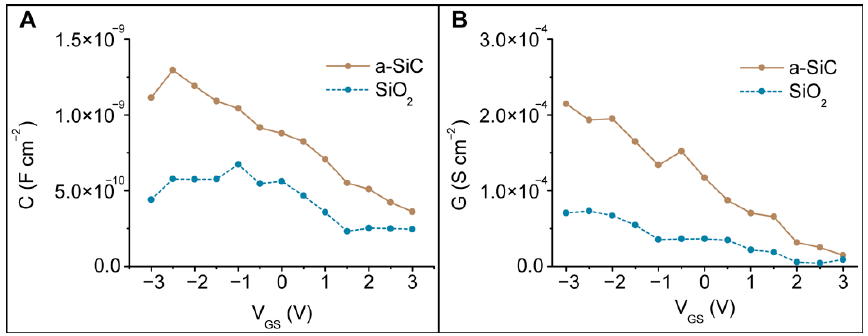
Figure 10. ( A ) Capacitance-voltage (C-V) and ( B ) conductance-voltage (G-V) data at a high frequency of 10 5 Hz evaluated on blank